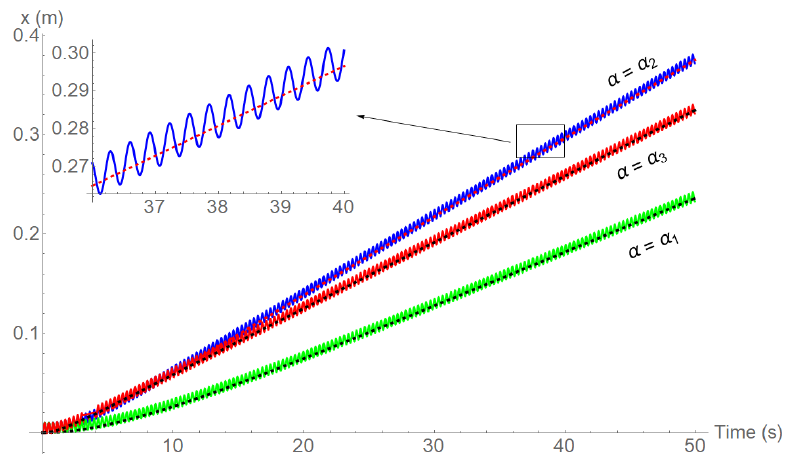
Figure 6. Displacement of the swimmer versus time for α 1 = 5 ◦ , α 2 = α m = 9.4 ◦ , and α 3 = 15 ◦ . Full: original system, dashed: averaged system.